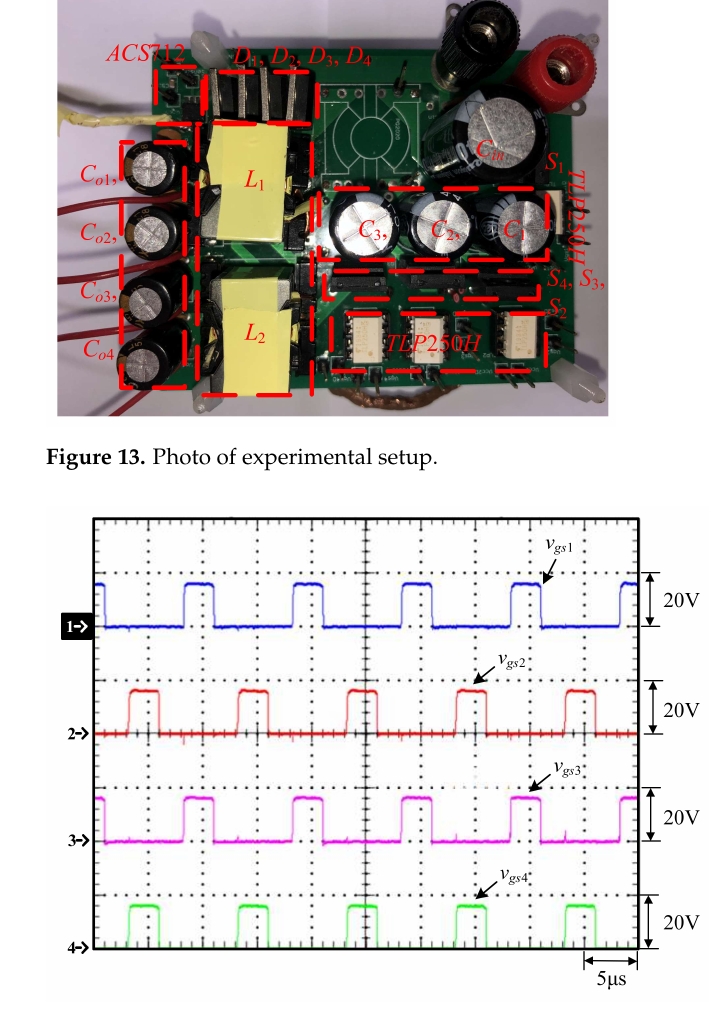
Figure 14. Measured waveforms relevant to rated load: (1) v gs 1 ; (2) v gs 2 ; (3) v gs 3 ; (4) v gs 4 .